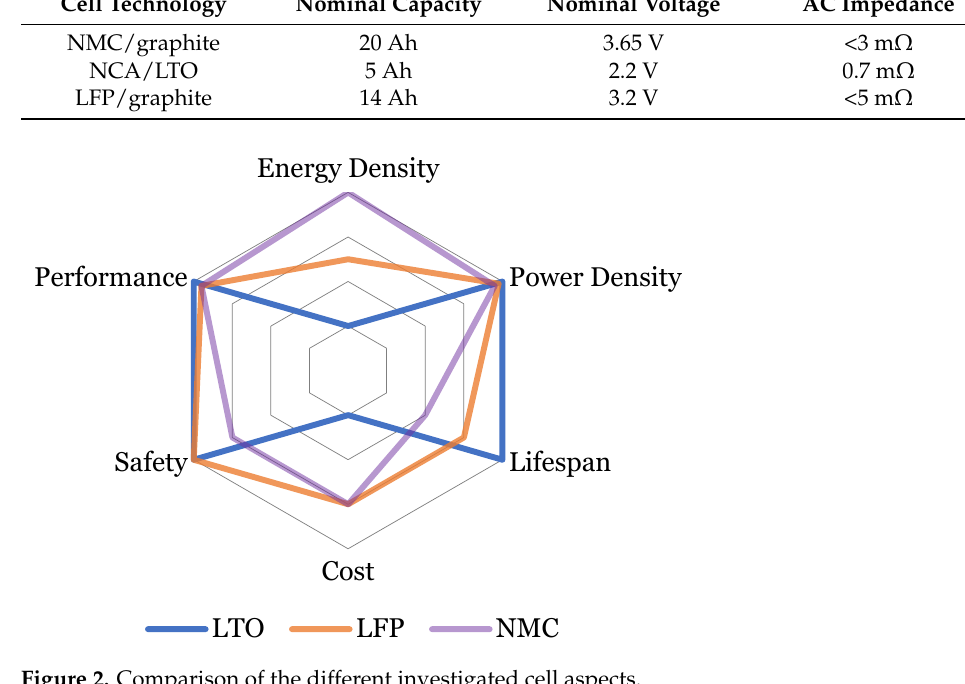
Figure 2. Comparison of the different investigated cell aspects.